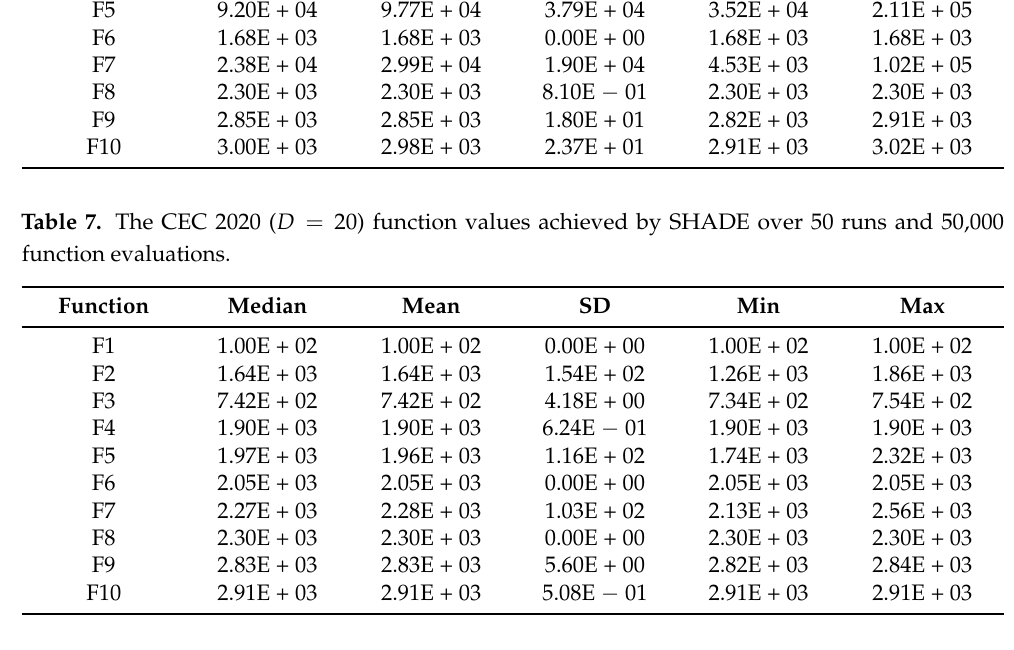
Table 8. The CEC 2020 ( D = 20) function values achieved by L-SHADE over 50 runs and 50,000 function